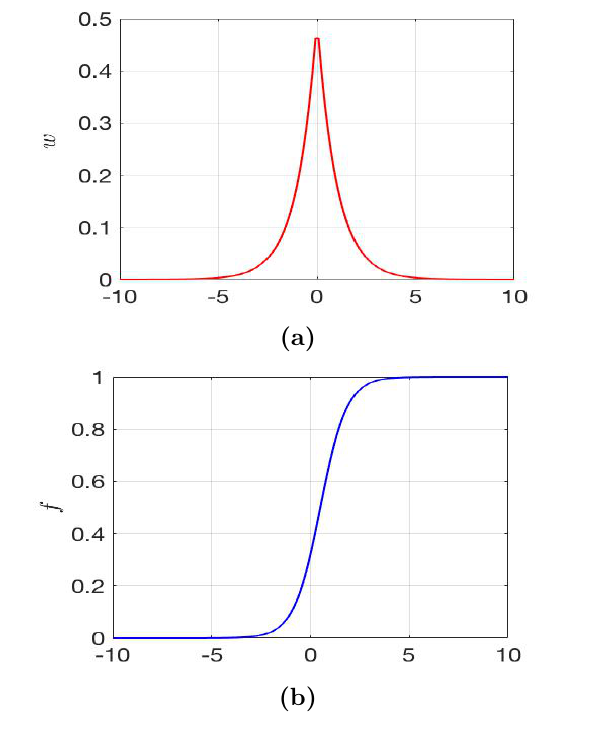
Figure 1. The synaptic kernel (a) and sigmoidal firing rate function (b) mimicking the interactions in the brain. Parameters are κ = 0 . 5, σ = 1 and µ = 1 .